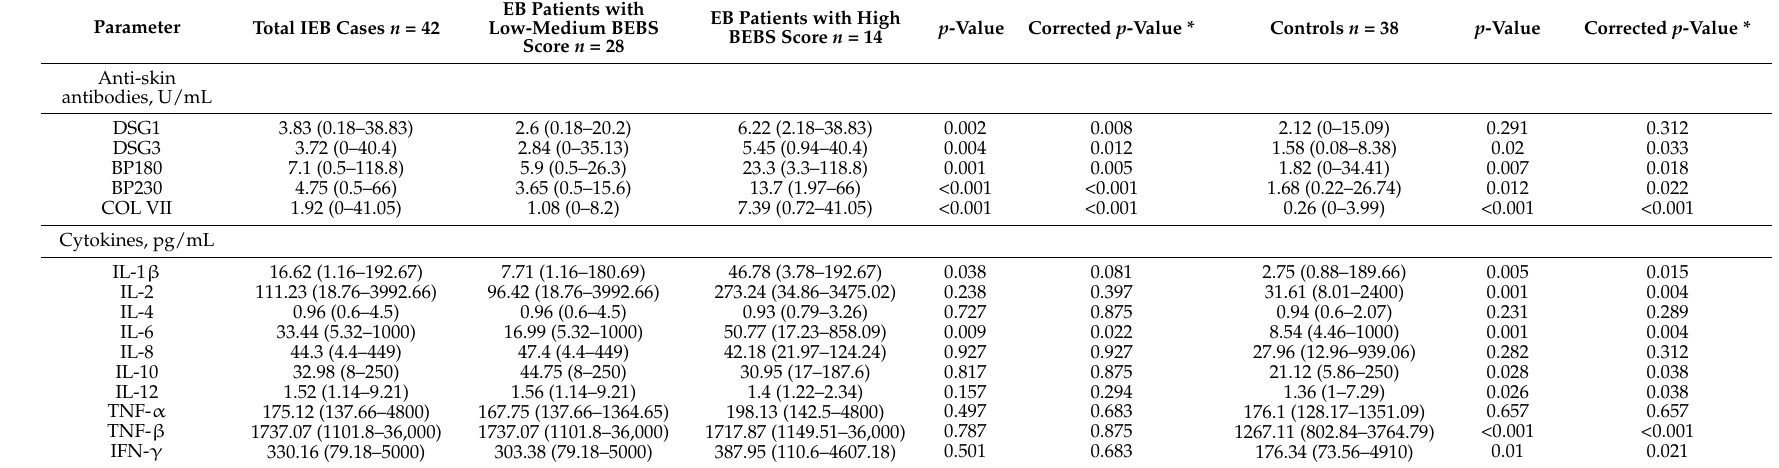
Table 4. Comparison of the studied variables in inherited epidermolysis bullosa patients according to their BEBS score and controls. EB Patients with EB Patients with High Parameter Total IEB Cases n = 42 Low-Medium BEBS BEBS Score n = 14 p -Value Corrected p -Value * Controls n = 38 p -Value Corrected p -Value Score n = 28